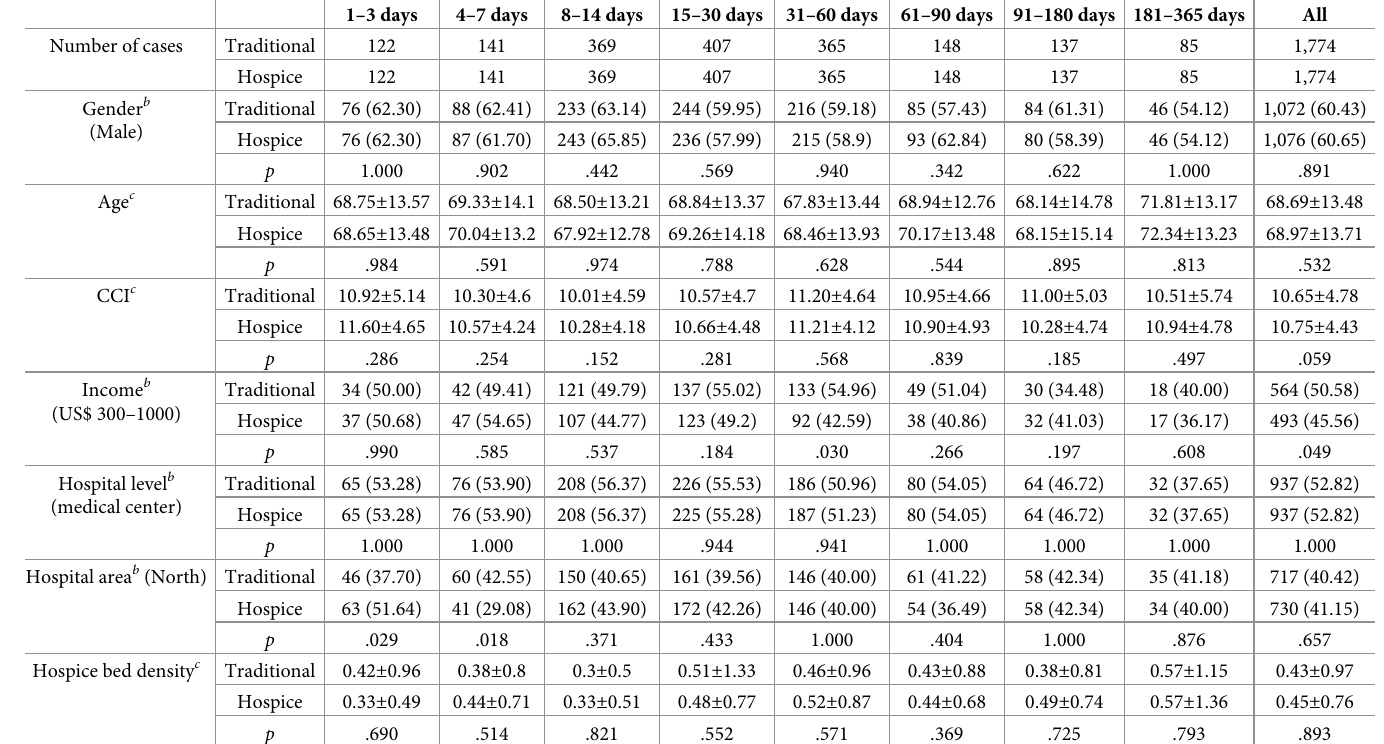
Table 2. Basic characteristics of terminal patients receiving traditional care or hospice care a